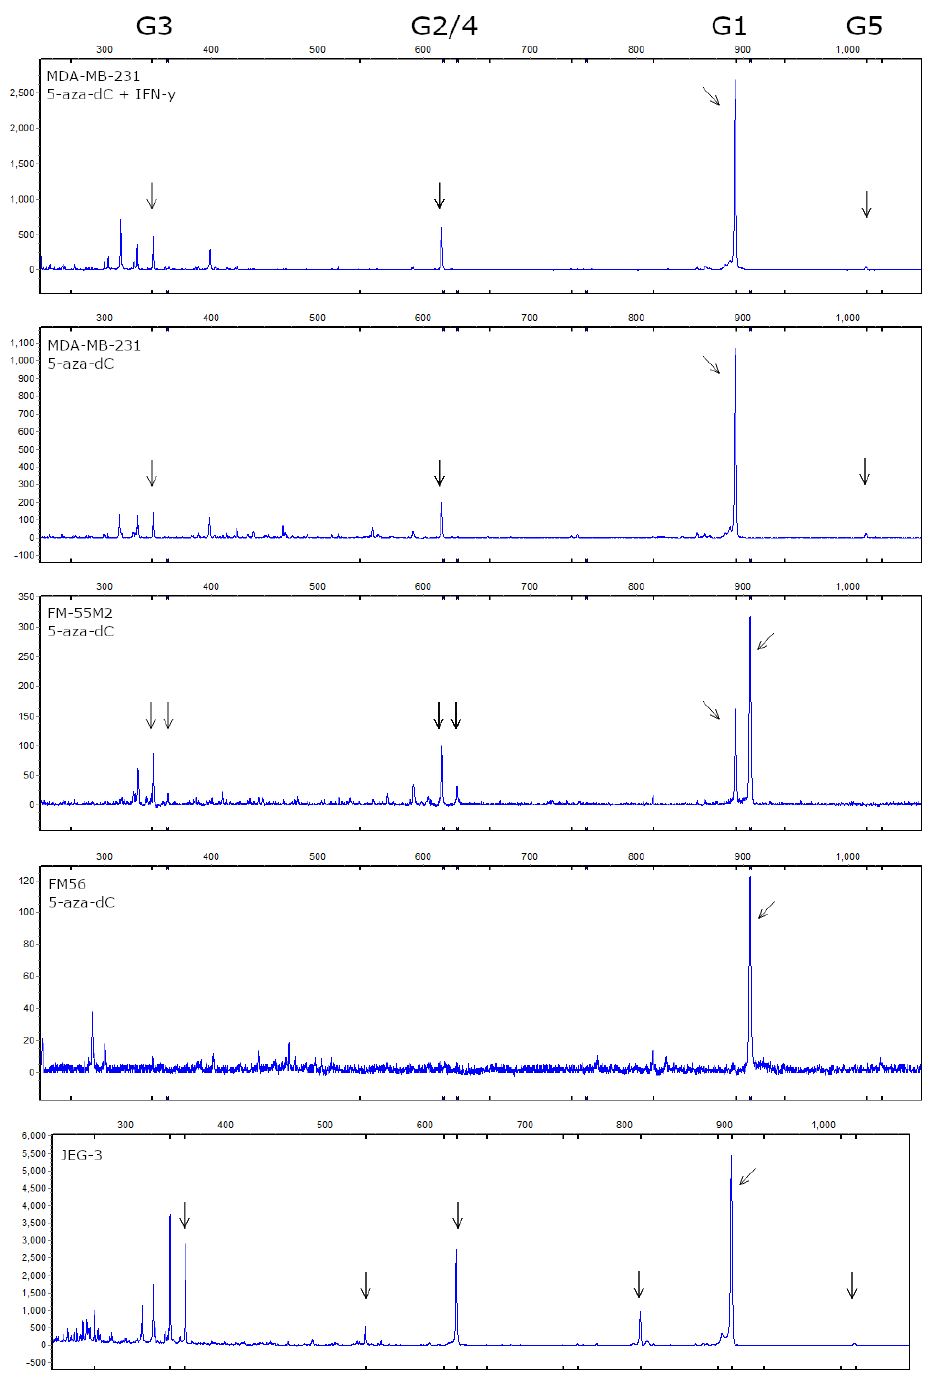
Figure 9. HLA-G isoform profile of stimulated breast cancer and malignant melanoma cell lines. Determination of HLA-G mRNA isoform expression was performed by fragment analysis. From the top is shown representative electropherograms from MDA-MB-231 cells treated with both 5-aza-dC and IFN- γ , and MDA-MB-231, FM-55M2 and FM-56 cells treated with 5-aza-dC, respectively. An electropherogram from the HLA-G-positive JEG-3 cell line is shown in the bottom as a positive control. Arrows highlight detected peaks corresponding to HLA-G1, -G2 / 4, -G3, and -G5 as listed on top. For FM-55M2 cells two peaks for each isoform indicate the heterozygous 14 bp ins / del phenotype with the additional + 14 bp isoform. For JEG-3 cells peaks corresponding to the 14 bp insertion and the Δ92 bp splice variant is detected.